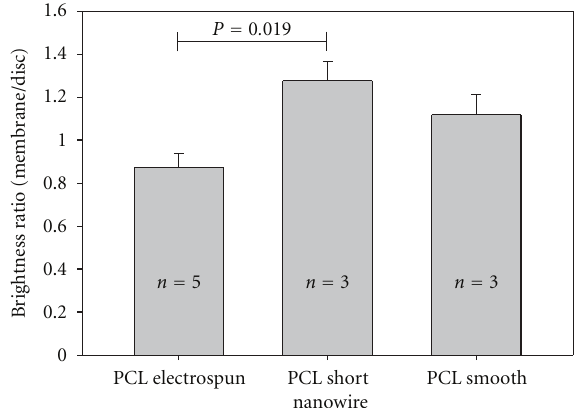
Figure 5: Mean brightness ratios for the three membrane types. Ratios are calculated as brightness of the membrane compared to that of the optic disc. Confidence intervals (thin bars) reveal a significant di ff erence between the poly( ε -caprolactone) (PCL) Electrospun and the PCL Short Nanowire membranes. Numbers of included animals for each membrane type are written on the broad